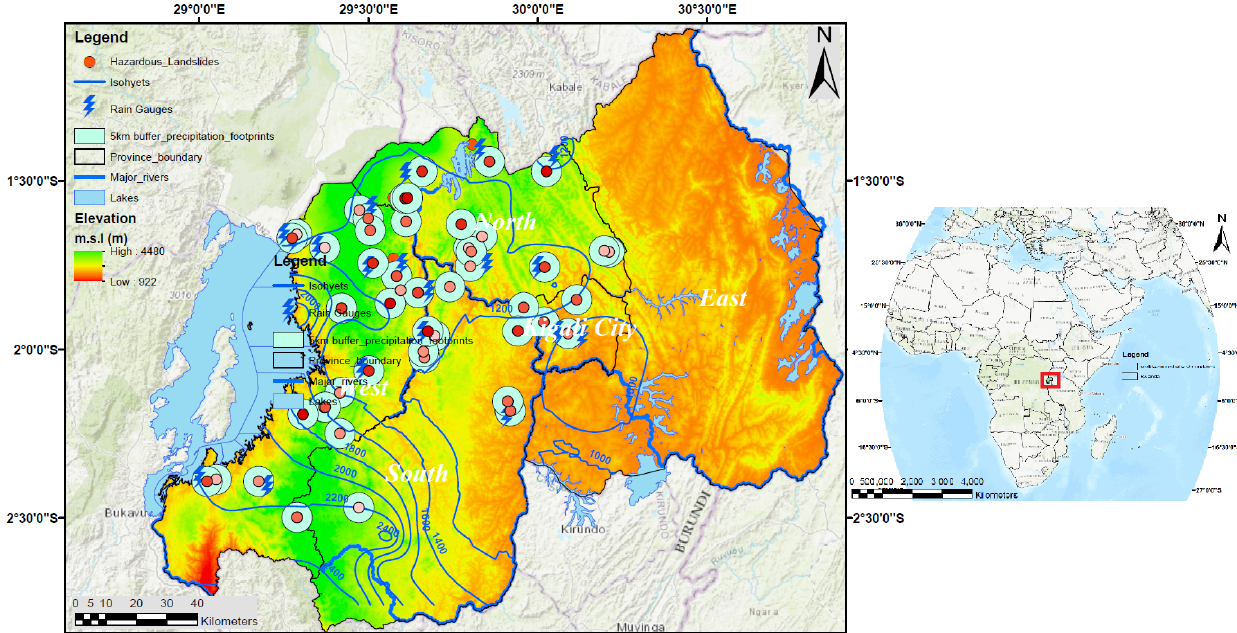
Figure 1. Location of Rwanda in Africa, elevation, spatial and temporal distribution of hazardous landslides with light to dark red dots indicating old to new landslides recorded from 2007 to 2019, landslide representative rain gauges, rainfall distributions indicated by isohyets (sky blue lines) and precipitation footprint of the 5km buffer around each landslide.